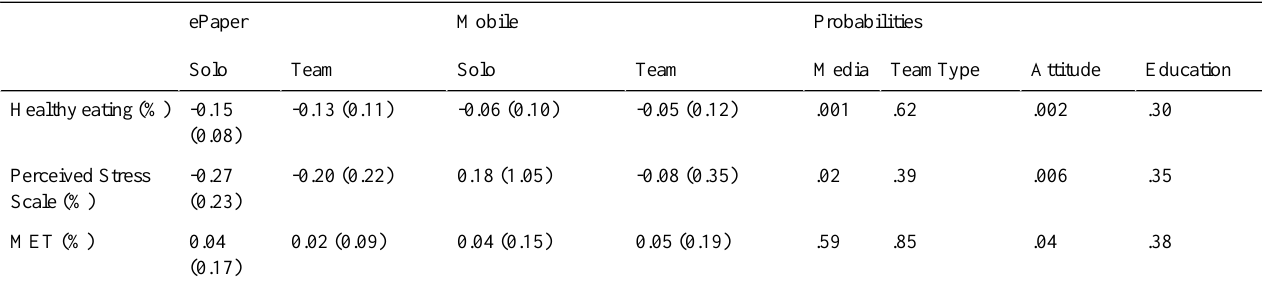
Table 4. Mean scores of percentage changes in Healthy Eating, Perceived Stress Scale, and MET, and the significance of 2 × 2 ANCOVAs.